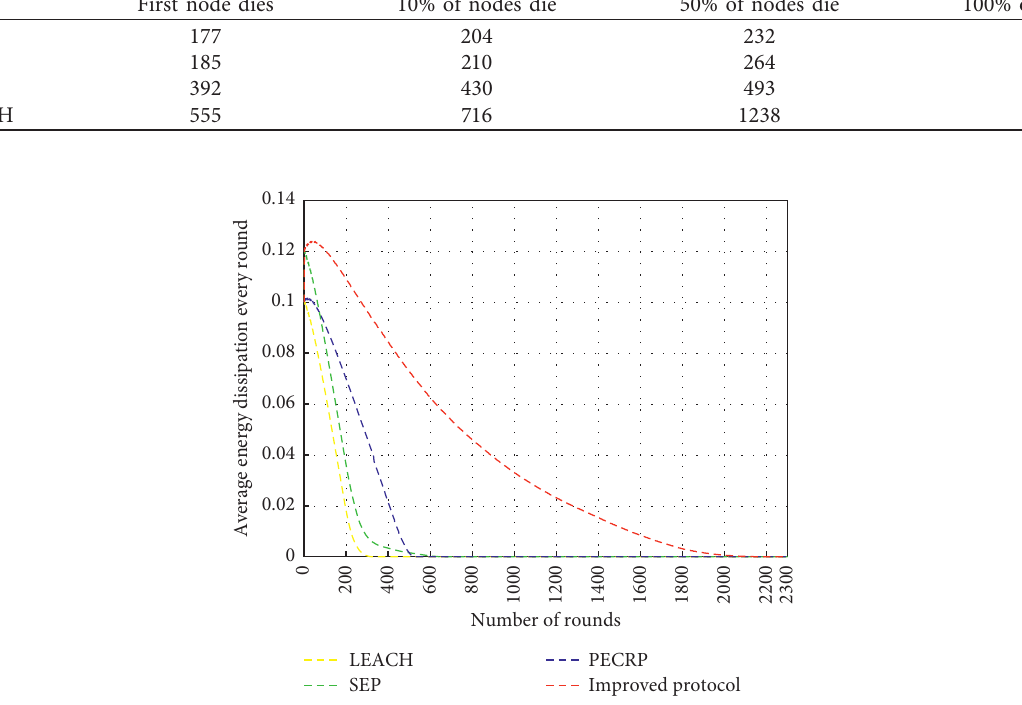
Figure 15: Comparison of average residual energy in each round with power supply.